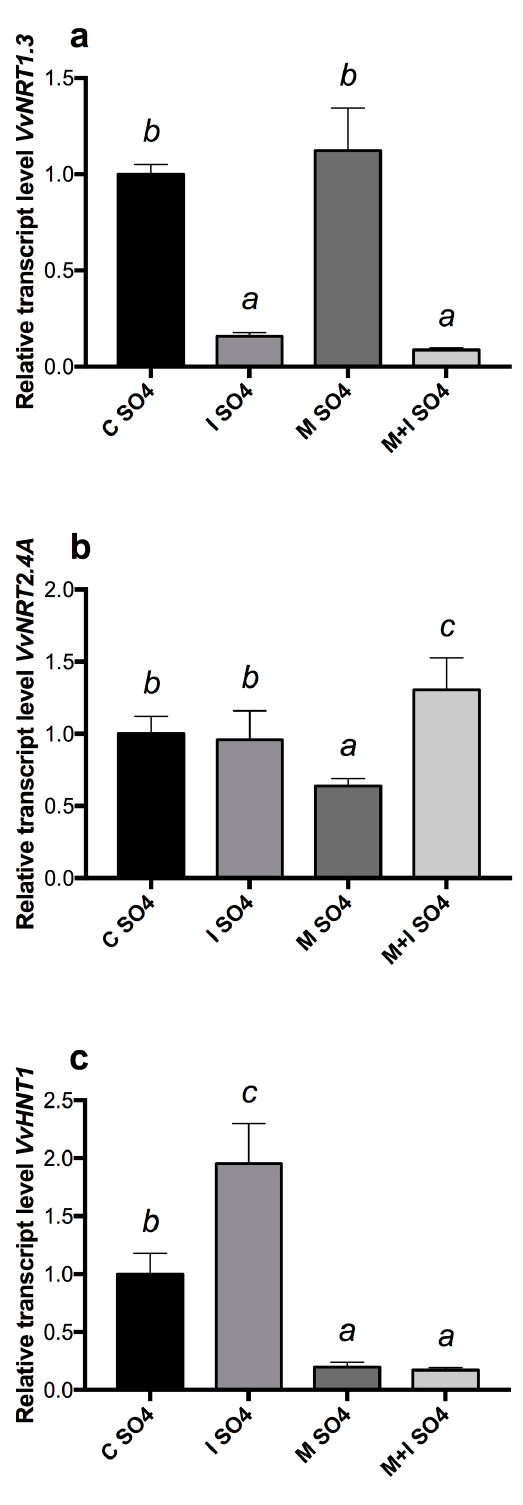
Figure 2. Expression changes of nitrogen-related genes in SO4 root. All data are expressed as mean ± SD ( n = 3). Different lowercase letters above the bars indicate significant differences according